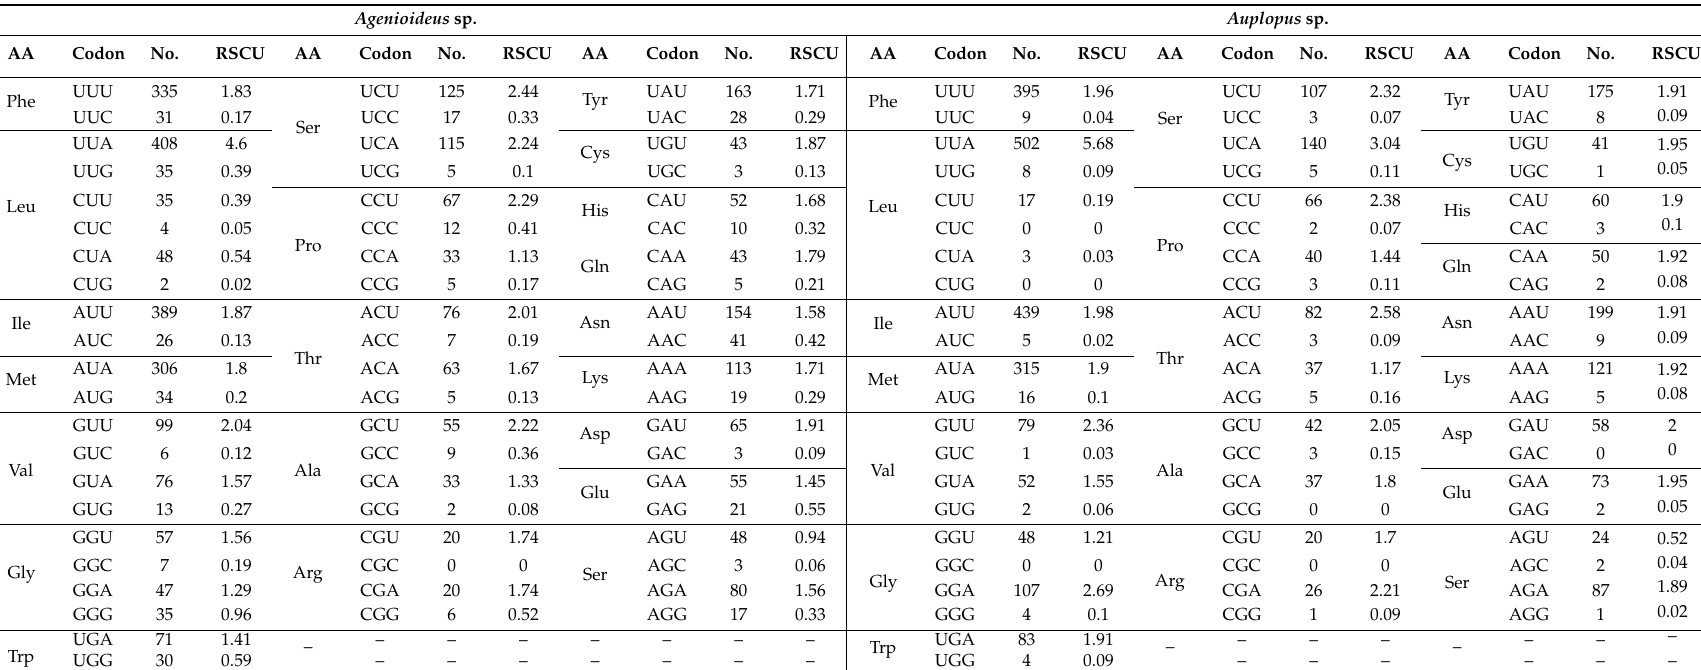
Table 3. Codon usage in the mitochondrial genomes of Agenioideus and Auplopus . Agenioideus sp. Auplopus